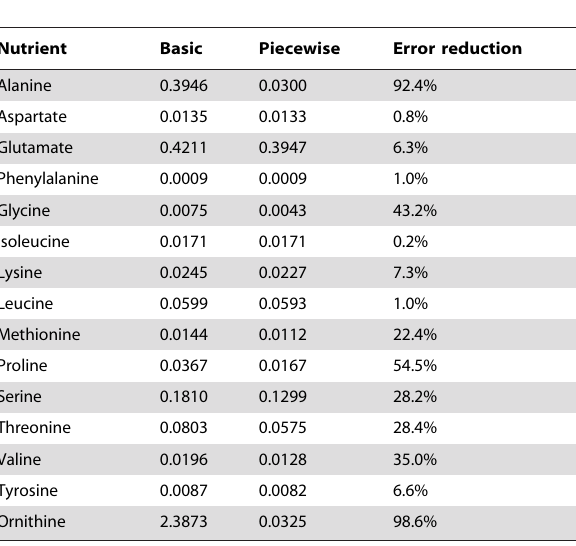
Figure 1. Proposed oxidative phosphorylation pathway. H. salinarum has analogs of all five respiratory complexes found in mitochondria and E. coli (complexes I to V). The boxes beneath each complex represent genes coding for specific subunits, which are often encoded adjacently in the genome (indicated by solid connections or by shared borders). Black broken lines are used to indicate that the connected genes, while not adjacent, are in the same genetic vicinity. The red broken line indicates that the cbaD and hcpB genes are fused in the archaeon. The proposed pathway has some notable differences from its more well-studied counterparts in E. coli or mitochondria. For example, genes coding for cytochrome c, which normally carries electrons to the terminal oxidase, could not be found in H. salinarum . Experimental evidence indicates that the function is likely performed by the copper protein halocyanin. doi:10.1371/journal.pcbi.1000332.g001 Table 1. Comparison of transport equation